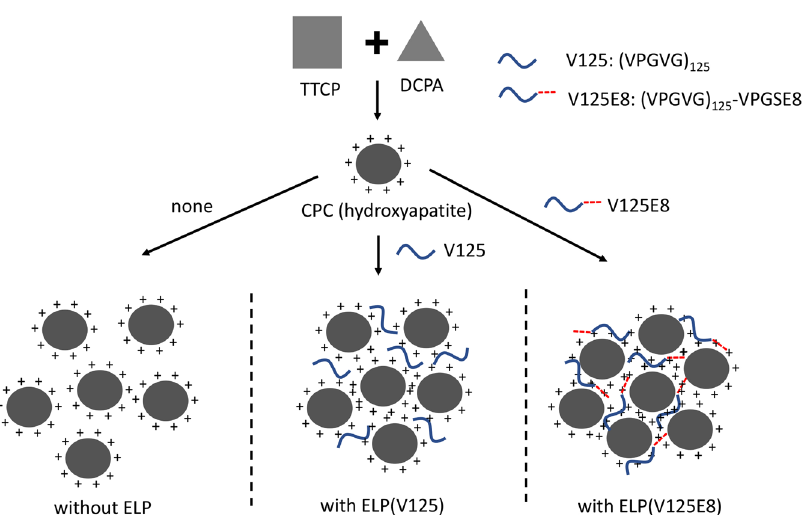
Figure 8. Schematic diagram of CPC supplemented with ELPs (V125 or V125E8). CPC containing a mixture of TTCP and DCPA sets as hydroxyapatite. ELP with negatively charged octaglutamic acid (V125E8)